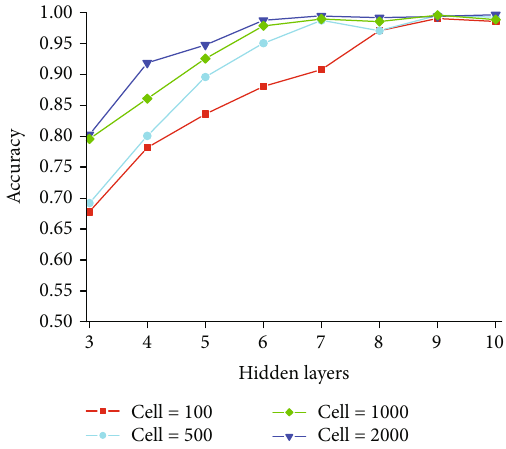
Figure 27: The accuracy using di ff erent numbers of hidden layers and neural